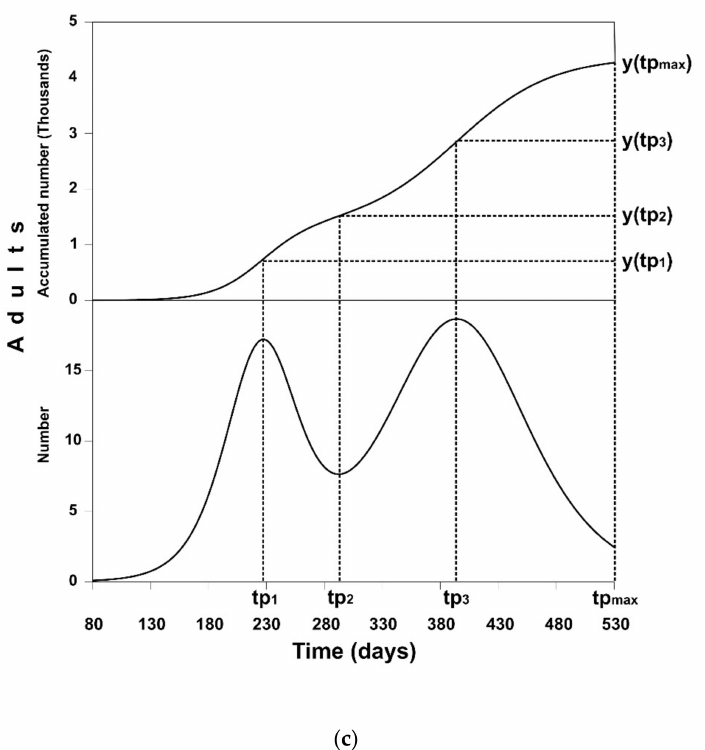
Figure 2. Mathematical models (double logistic functions) fitted to the accumulated data of the palm pest species, Rhynchophorus ferrugineus ( a ) larvae, ( b ) pupae and ( c ) adults stages, also displaying the corresponding bimodal density time functions.